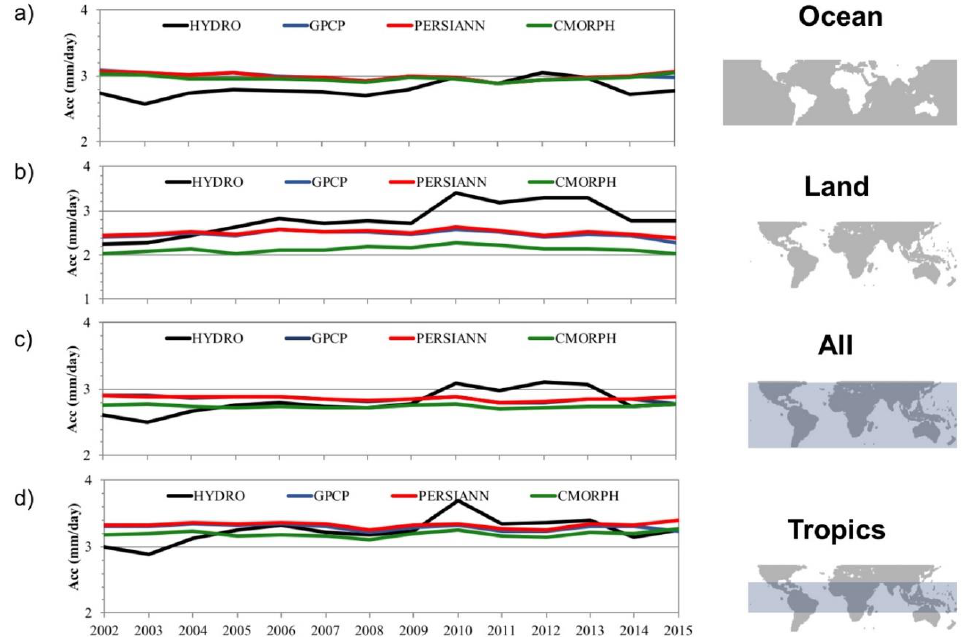
Figure 4. Comparison of average annual precipitation for the HBC and other gridded satellite products of the CDR program (GPCP, PERSIANN, CMORPH). Comparisons are conducted for the band 50°N – 50°S: ( a ) over ocean, ( b ) over land, ( c ) globally, and ( d ) for the tropics 23°N – 23°S.